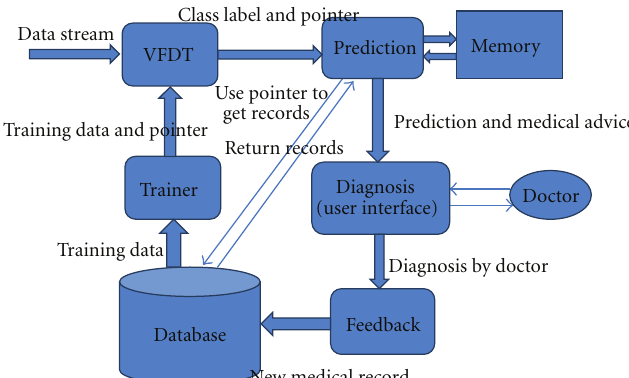
Figure 1: Logical structure of our design.